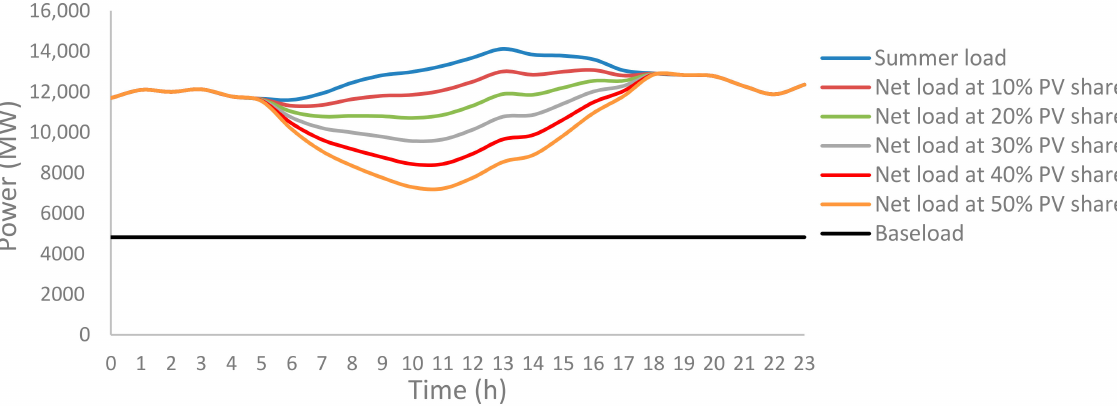
Figure 12. The impact of the PV system penetration level on the grid in terms of net load during the summer